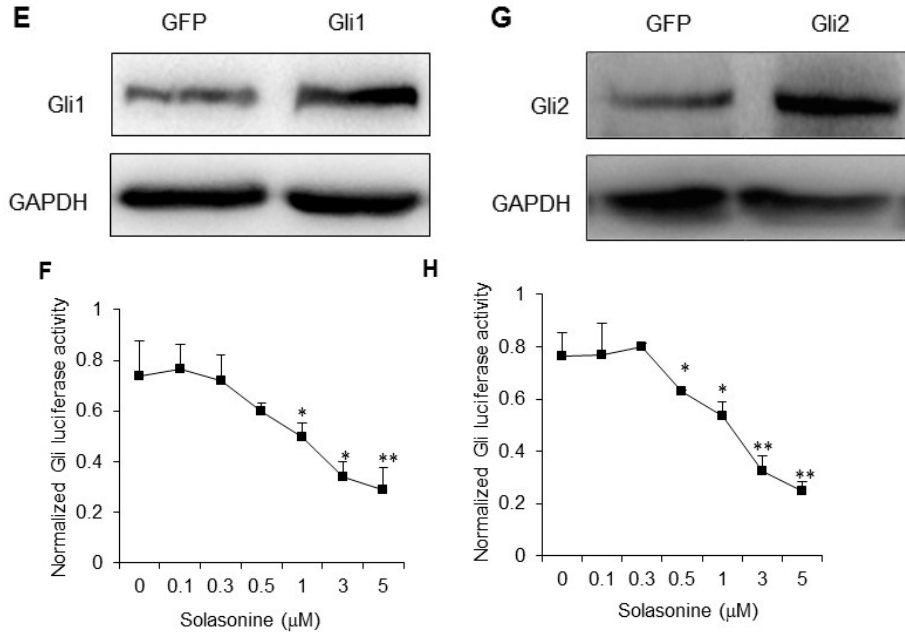
Figure 4. Solasonine inhibits the Hh signaling pathway by targeting Gli ( A ) Solasonine dose-dependently inhibits the Gli-luciferase activity provoked by SAG. The results are expressed as mean ± s.d.; ( B ). Expression of Sufu in NIH-3T3 cells infected with lentivirus carrying Sufu shRNA or shRNA control. The cells infected with various types of lentivirus were collected for Western blot analyses. Immunoblotting of GAPDH served as a loading control; ( C , D ) Solasonine suppressed the mRNA expression of Gli1 ( C ) and ptch1 ( D ) caused by limiting Sufu expression. The results are expressed as mean ± s.d.; ( E ) Ectopic expression of Gli1 in light II cells as examined by western blot analysis; ( F ) Solasonine suppressed the Gli-luciferase activity caused by exogenous expression Gli1 in a dose-dependent manner. Data are expressed as mean ± s.d. ( n = 3); ( G ) Ectopic expression of Gli2 in light II cells as examined by western blot analysis; ( H ) Solasonine suppressed the Gli-luciferase activity caused by exogenous expression Gli2 in a dose-dependent manner. Data are expressed as mean ± s.d. ( n = 3). Statistical differences were analyzed by the two-tailed Student ′ s t test and p < 0.05 was considered as significant (* p < 0.05; ** p < 0.01).